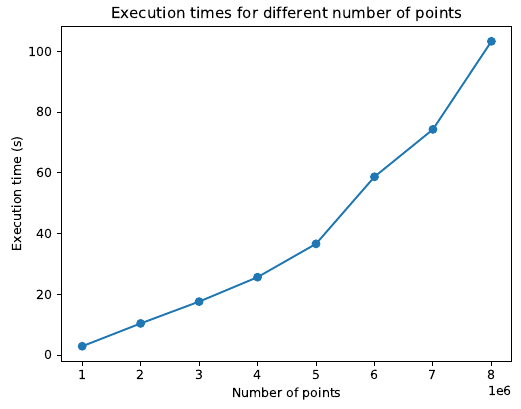
Figure 11. Execution times for different number of points.